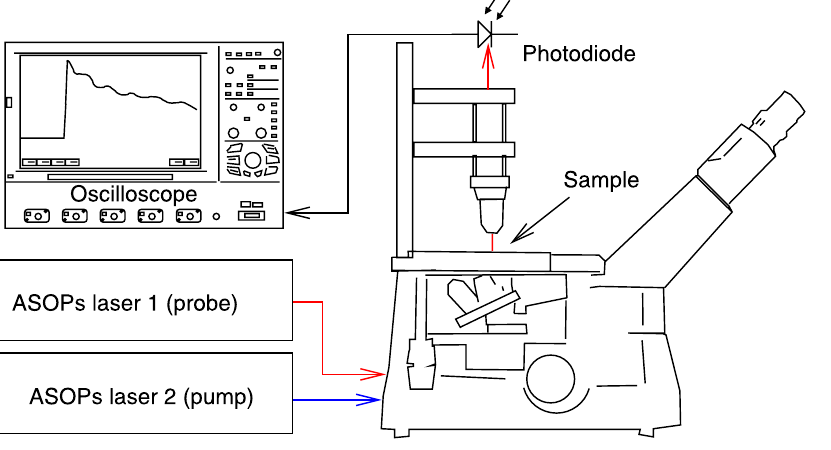
Figure 6. Schematic of the super-resolving phononic